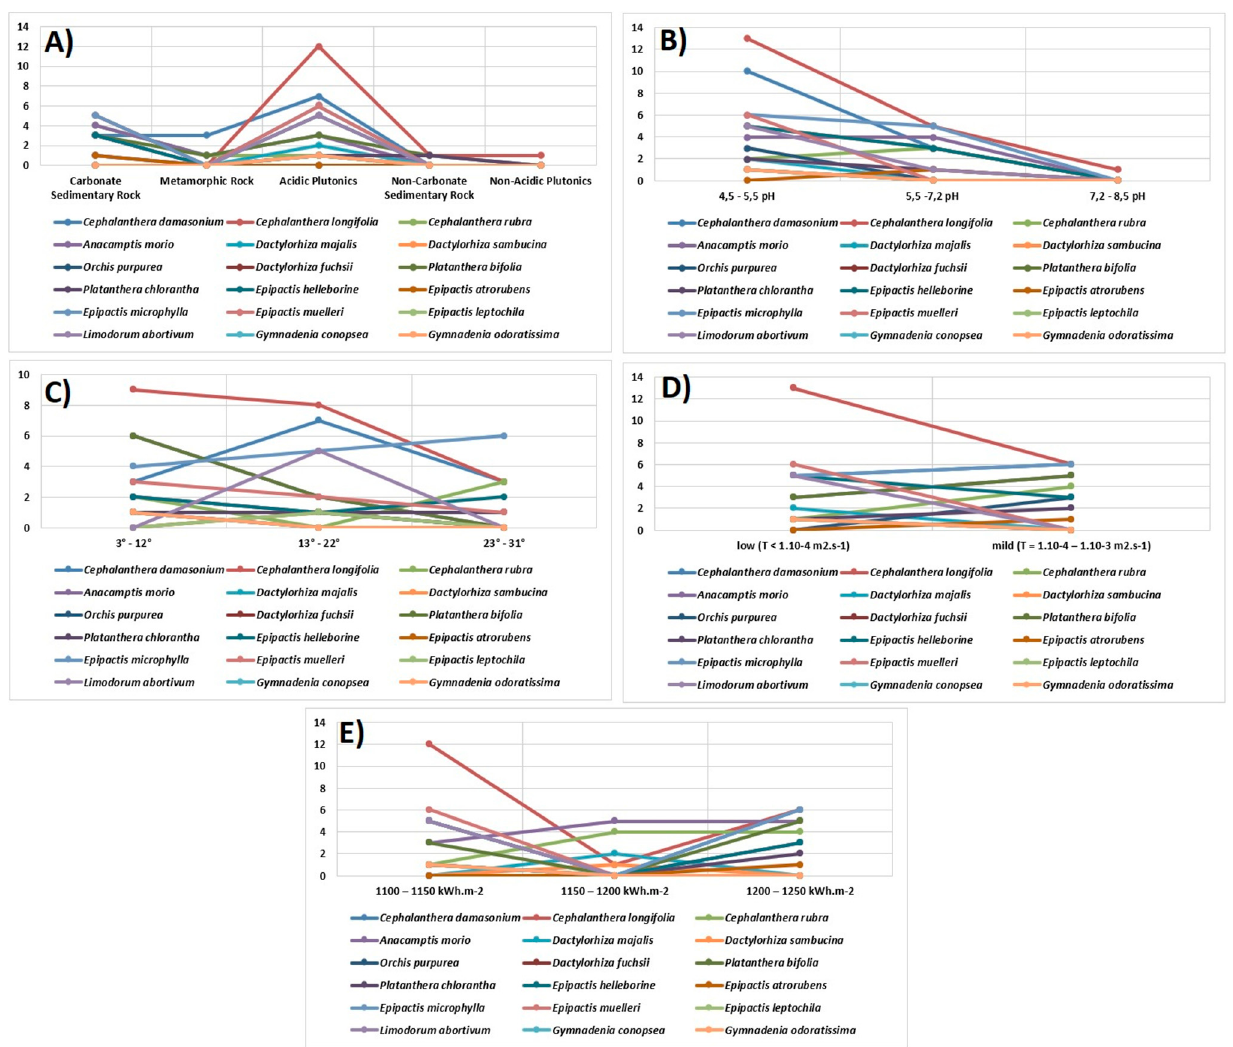
Figure 5. Graphical evaluation of ecological factors: ( A ) Substrate: ecological land unit value, ( B ) Soil reaction (pH), ( C ) Terrain: slope ( ◦ ), ( D ) Flow and hydrogeological productivity (m 2 .s − 1 ), ( E ) Average annual amounts of global radiation (kWh.m –2